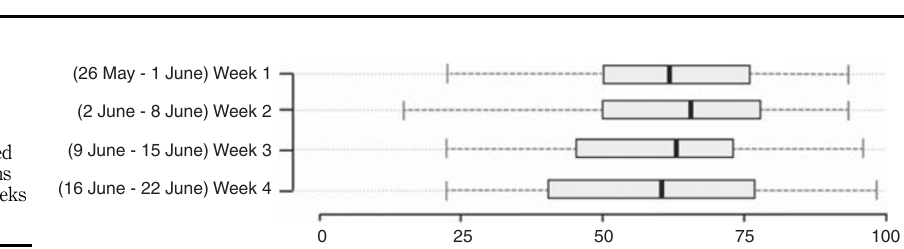
Table I. Percentage of correct responses to the objective questions in the survey